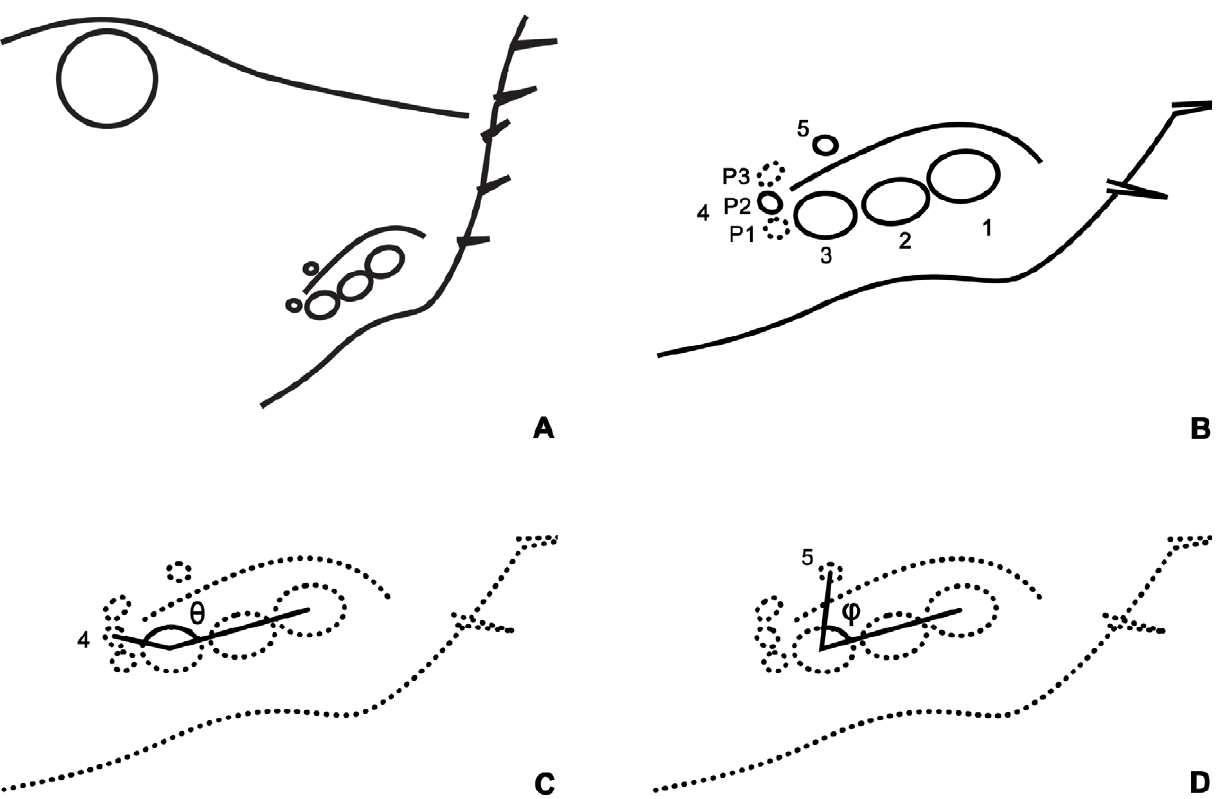
Figure 1. Models of lateral eye area. (A) The position of lateral eye area on Carapace; (B) Supposed model of 5 lateral eyes, P1, P2, P3 are 3 possible locations of the No. 4 lateral eyes; (C) Angle h , indicating the location of No. 4 lateral eye; (D) Angle w , indicating the location of No. 5 lateral eye. 1. The position of No. 4 could be variable. On the carapace (dorsal view), three types were apparent: (1) Posterior-lateral (Figure 1. B P1), similar to the positions of No. 1–3, (2)